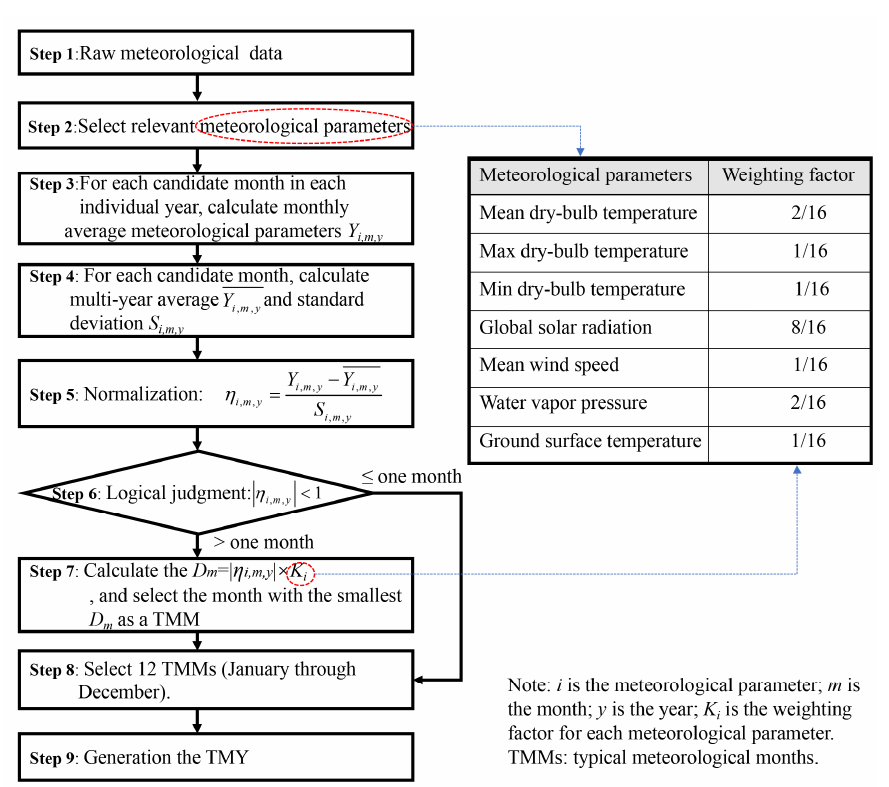
Figure 6. The procedures of the Chinese standard weather database (CSWD)